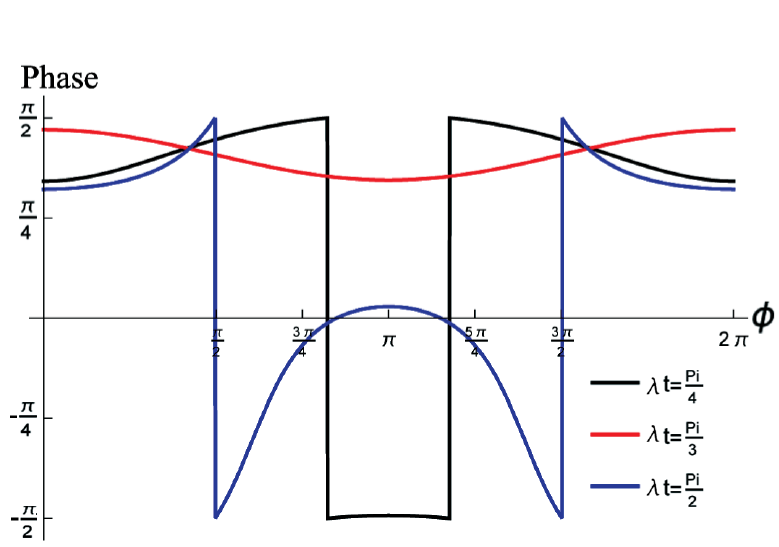
Figure 2. The evolution of Pancharatnam phase Φ ( φ )